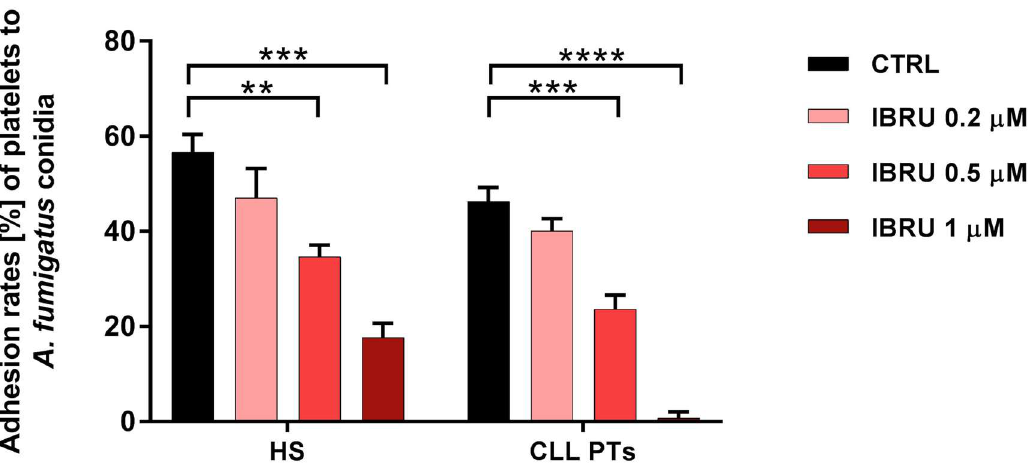
Figure 2. Ibrutinib inhibits adhesion of platelets to conidia. Platelets, treated or not treated with three different concentrations of ibrutinib (0.2 µ M, 0.5 µ M, and 1 µ M), were incubated with A. fumigatus conidia, at an effector-to-target (E:T) ratio of 100:1 for 30 min at 37 °C, and then centrifuged at low intensity. Then, the OD 700 of the supernatant was determined by spectrophotometer, and the percentage of platelet adhesion was calculated in relation to the OD 700 of platelets and conidia alone (** p < 0.01; *** p < 0.001; **** p < 0.0001). HS, healthy subjects; PTs, patients; CTRL, control; IBRU, ibrutinib.